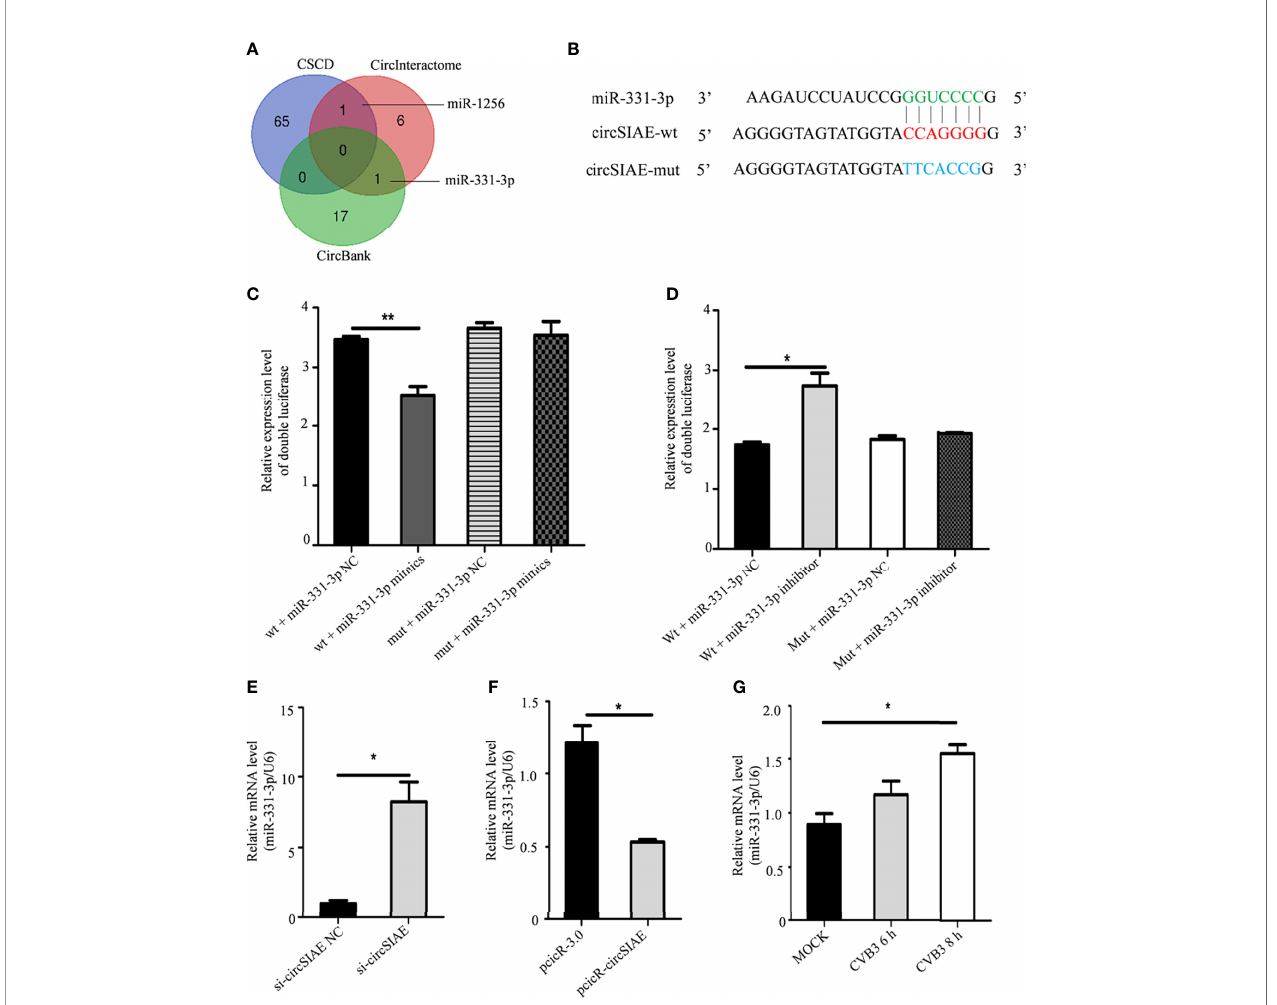
FIGURE 3 | The search for downstream target miRNAs of circSIAE. (A) Potential downstream target miRNAs of circSIAE were searched for in bioinformatics databases. (B) Wild-type and mutant sequences of circSIAE. (C, D) After 293T cells were transfected with NC/mimics/inhibitor of miR-331-3p and wild type, and circSIAE was knocked down for 24 h, the ratio of fi re fl y luciferase to Renilla luciferase was measured with a dual luciferase kit. (E, F) Total RNA was extracted from HeLa cells after transfection with pcicR-circSIAE/si-circSIAE for 36 h, and the expression level of miR-331-3p was detected by qRT-PCR. (G) qRT-PCR was used to verify the relationship between miR-331-3p and CVB3. *p < 0.05, **p <